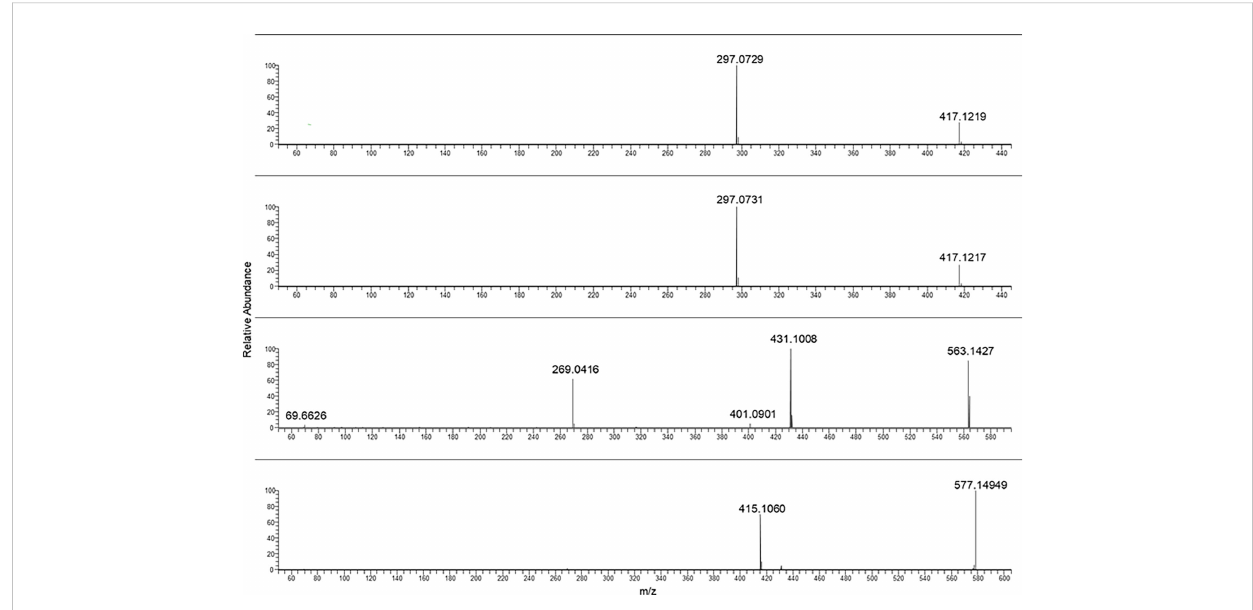
FIGURE 2 From the top to bottom: Aloin B aloin A glucofrangulin B and glucofrangulin A MS/MS